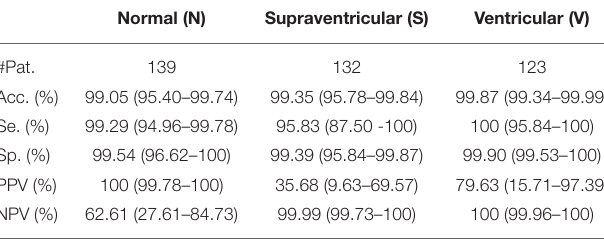
TABLE 5 | Patient-based classifier performance, median (IQR range) for the multi-class